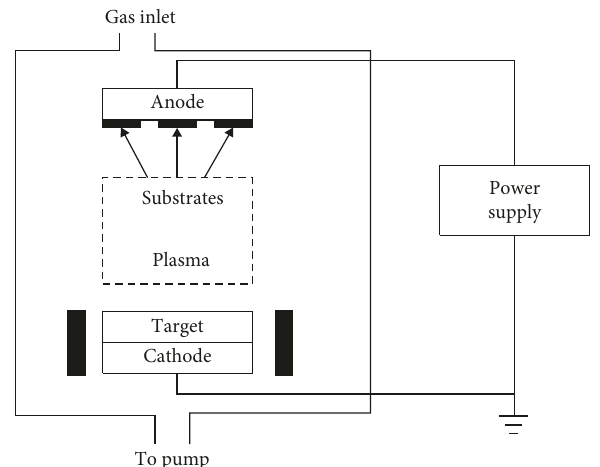
Figure 1: Schematic diagram of the magnetron sputtering